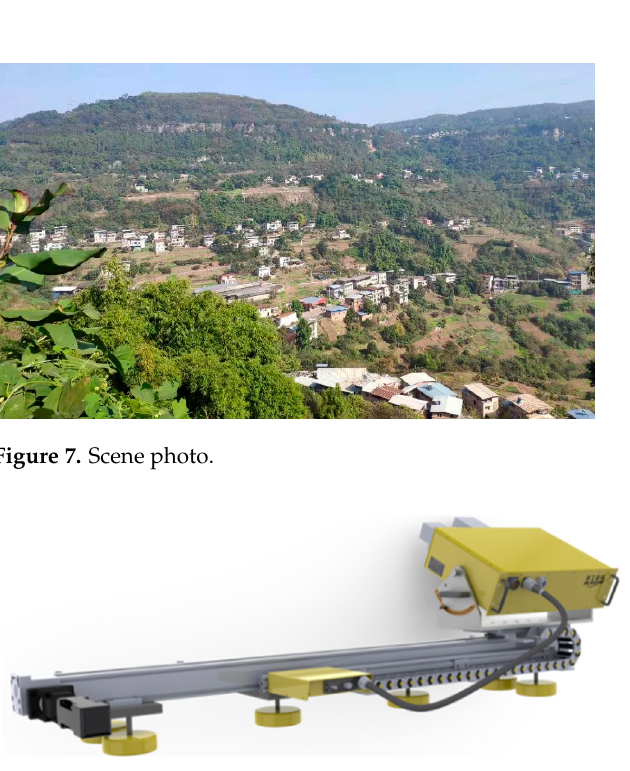
Table 1. Parameters of the GB-SAR system.